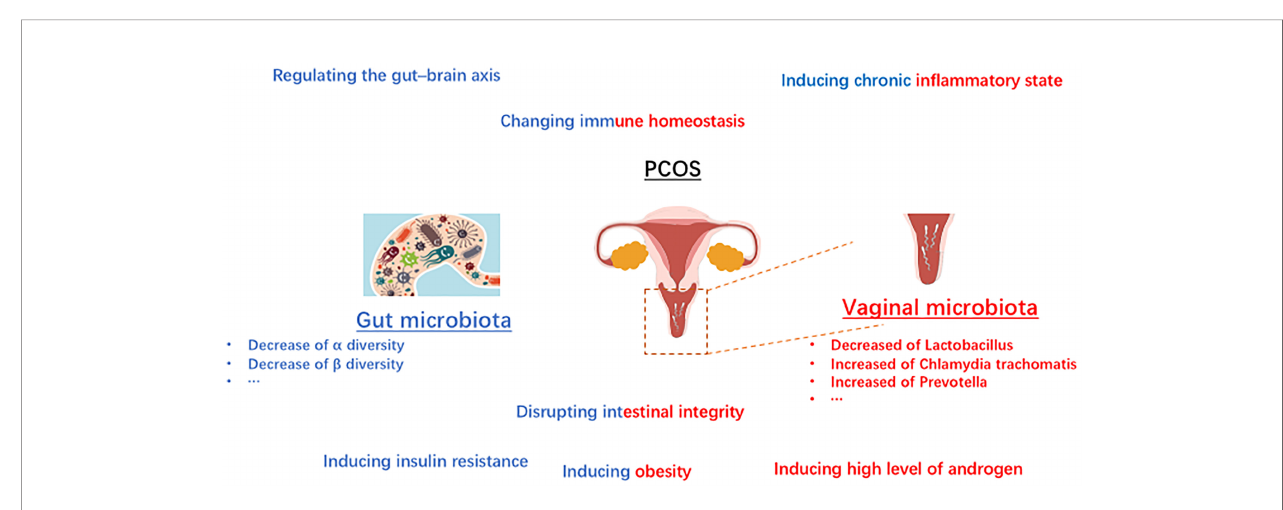
FIGURE 2 | Schematic diagram showing the composition changes and mechanisms microbiota in PCOS.